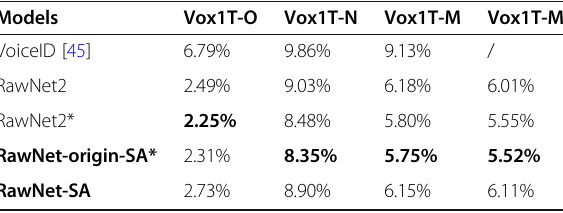
Table 8 Anti-noise test of different models